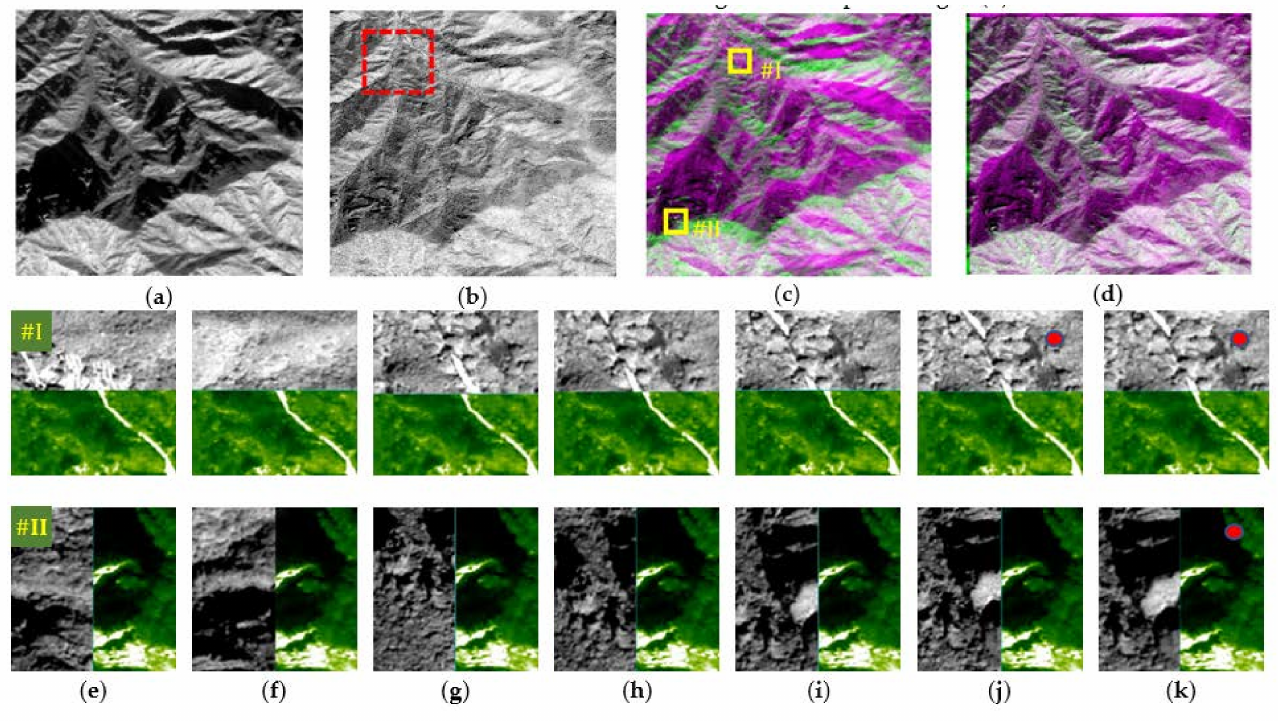
Figure 8. Registration results of image pairs in ecological reserves. ( a ) Reference image (3600 × 3900 pixels). ( b ) Sensed image (3600 × 3900 pixels). ( c ) The overlap of the original im- ages (shown in pseudo color). ( d ) The overlap of the reference image and the result of the proposed algorithm. Magnified images (160 × 160 pixels) from ( e ) the original images, ( f ) RRM, ( g ) PLM, ( h ) APAP, ( i ) OFM, ( j ) LRC-BRE-BR, and ( k ) CCFR. In them, the green area of the magnified images is the reference image, and the gray area is the registered image. A red point suggests that the processed image is well-aligned with the reference